Question: Condense the content of this figure into a single sentence.
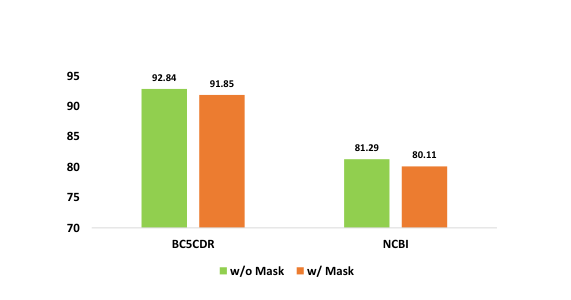
Answer: LLM performance on without (w/o) mask operation and with (w/) mask operation